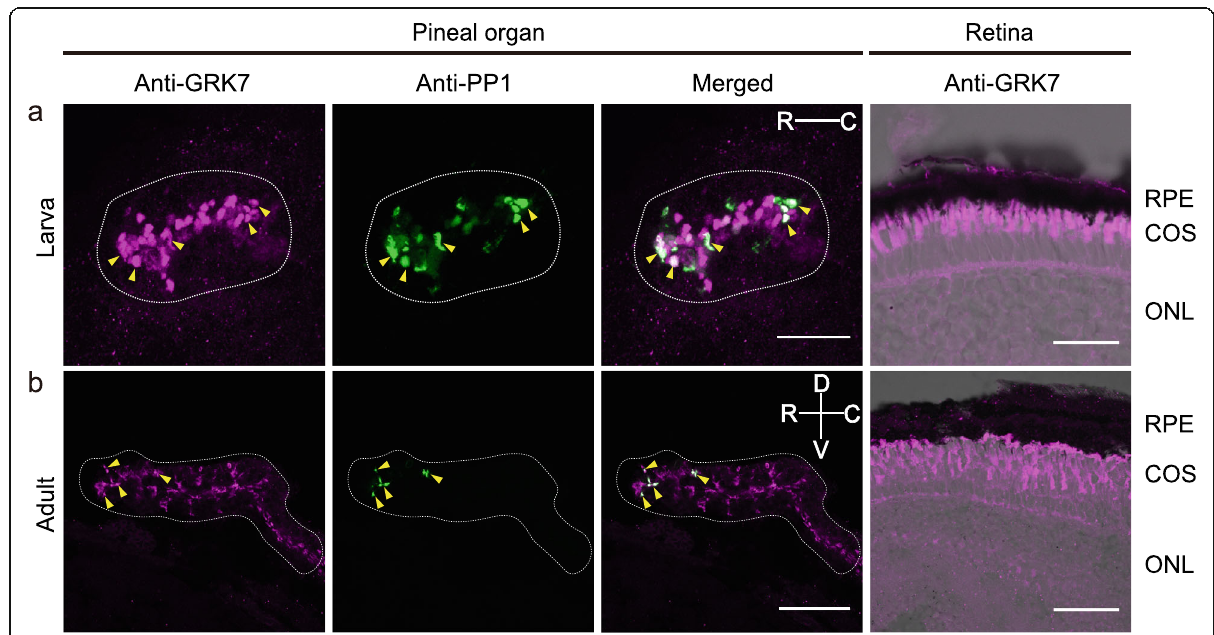
Fig. 3 Immunoreactivity of the anti-GRK7 antibody in the PP1 cells of zebrafish larvae and adults. Double immunostaining for GRK7 (magenta) and PP1 (green) in the pineal organ and retina of larval and adult zebrafish using anti-PP1 and anti-GRK7 antibodies. a Zebrafish larva (5 dpf, whole-mount preparations); scale bars represent 20 μ m. The rostral (R) and caudal (C) sides are shown. b Adult zebrafish (tissue sections); scale bars represent 50 μ m. The merged image demonstrates that GRK7 is colocalized with PP1 (yellow arrowheads). The white dotted traces indicate the landmarks of the pineal organ. The rostral (R), caudal (C), dorsal (D), and ventral (V) sides are